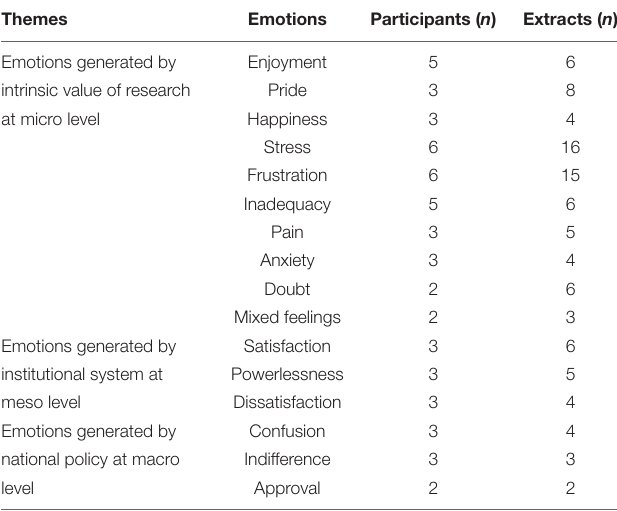
TABLE 3 | The participants’ emotions in research.